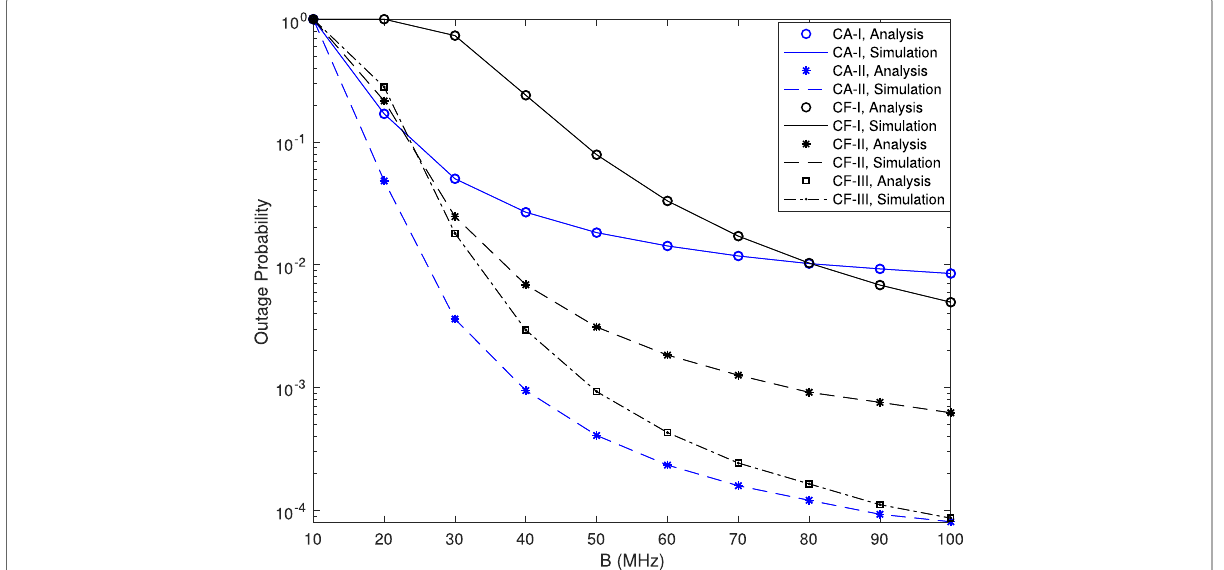
Fig. 6 Outage probability versus B when N = 2, L = 50Mbits, K = 10, P /σ 2 = 15dB and T =